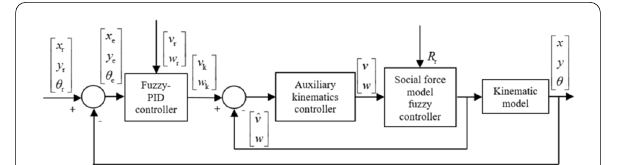
Figure 9 Combination autonomous behavior strategy design